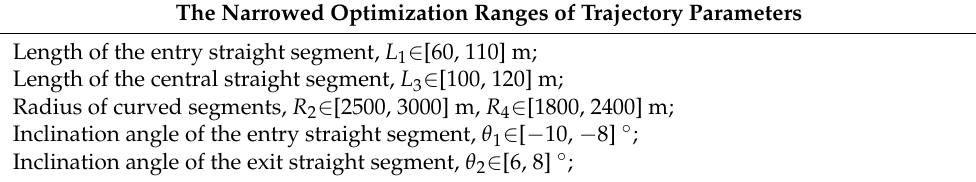
Table 5. The narrowed optimization ranges of trajectory